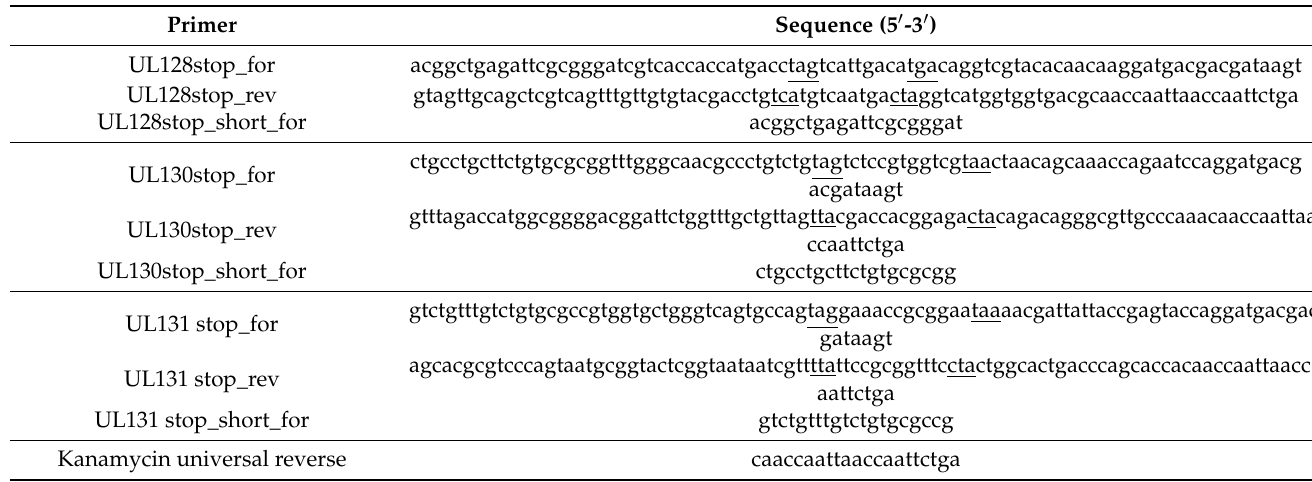
Table 2. Primers used for the introduction of stop codons into genes of the UL128 locus.